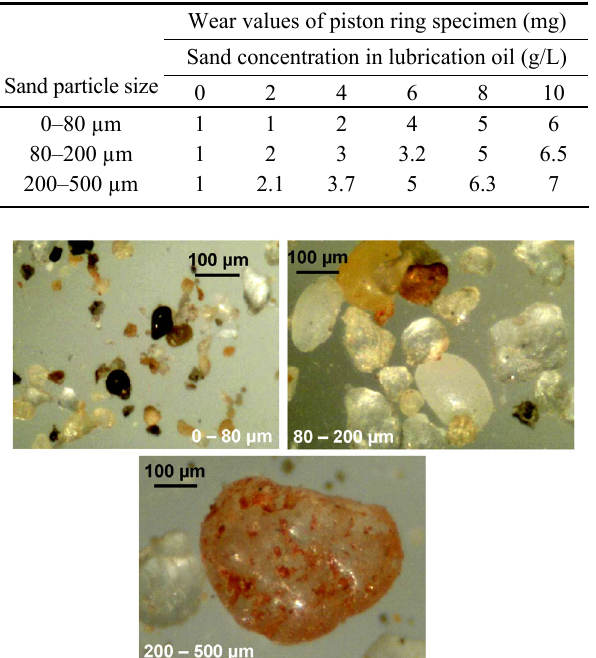
Fig. 13 Effect of sand contamination in lubricant on wear for sand particles of size 200–500 µm. Fig. 14 Photomicrographs of sand dispersed in lubrication